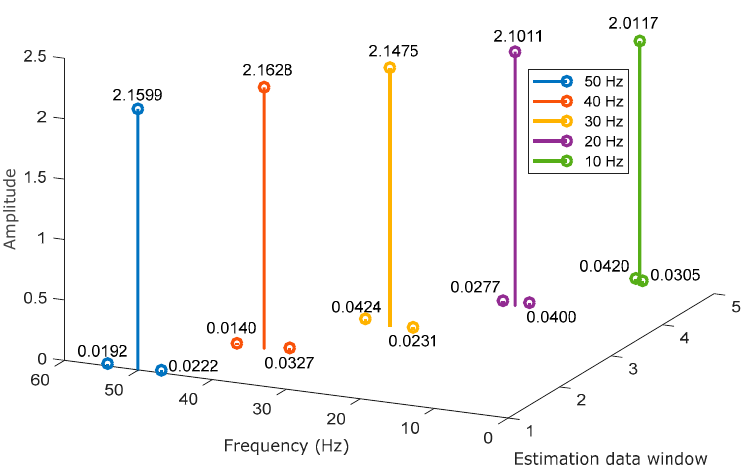
Figure 21. Prony estimated spectrum of VFD frequency speed operation scenarios.